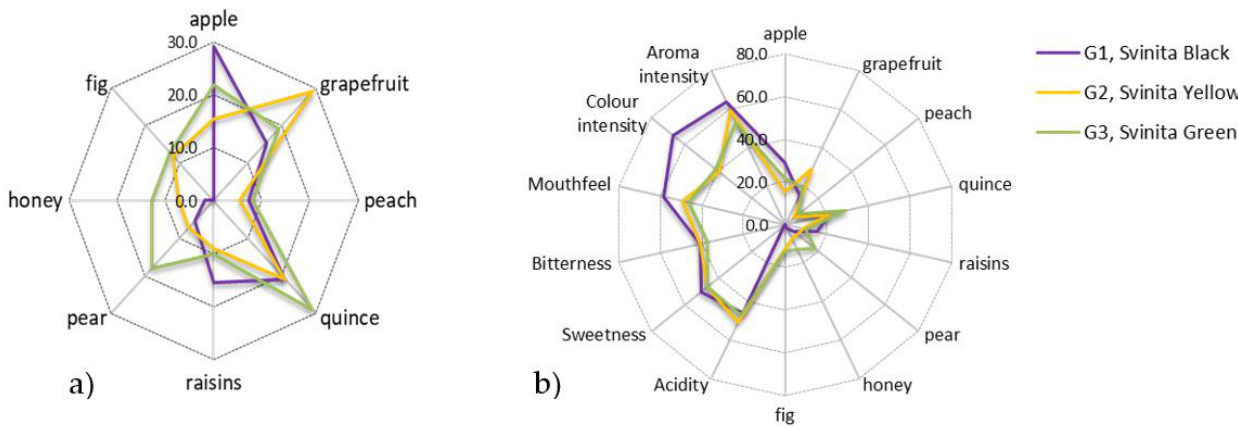
Figure 7. Aroma profiles ( a ) and total sensory profiles ( b ) of the alcoholic beverage produced from the three fig the three fig varieties.